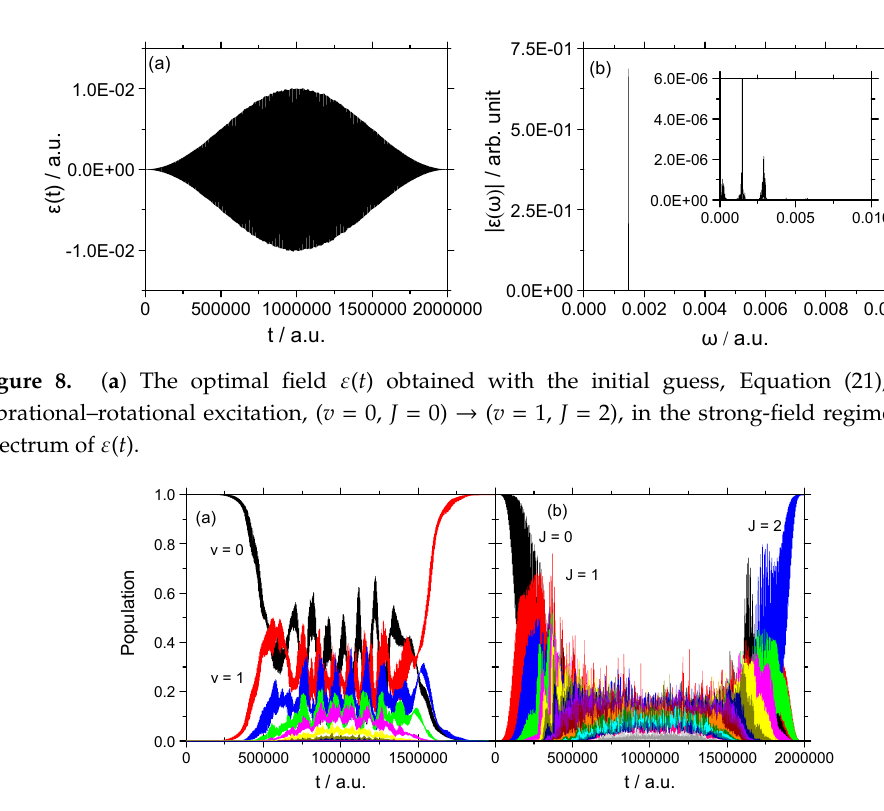
Figure 9. Temporal changes in state populations for the vibrational–rotational excitation, ( v = 0, J = 0) → ( v = 1, J = 2), caused by the optimal field shown in Figure 8, in the strong-field regime: ( a ) vibrational states; ( b ) rotational states.